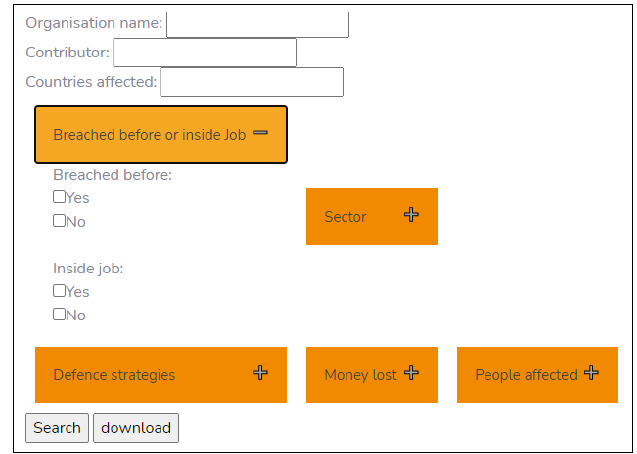
Figure 2. The search form has numerous options for filtering the